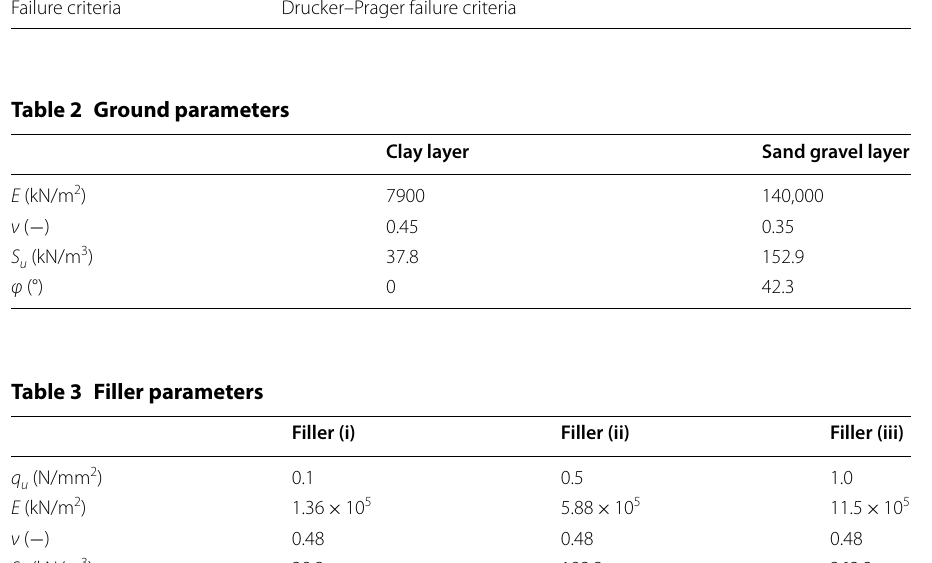
Table 1 Element parameters for ground and filler Clay layer Sand gravel layer Filler γ t (kN/m 2 )